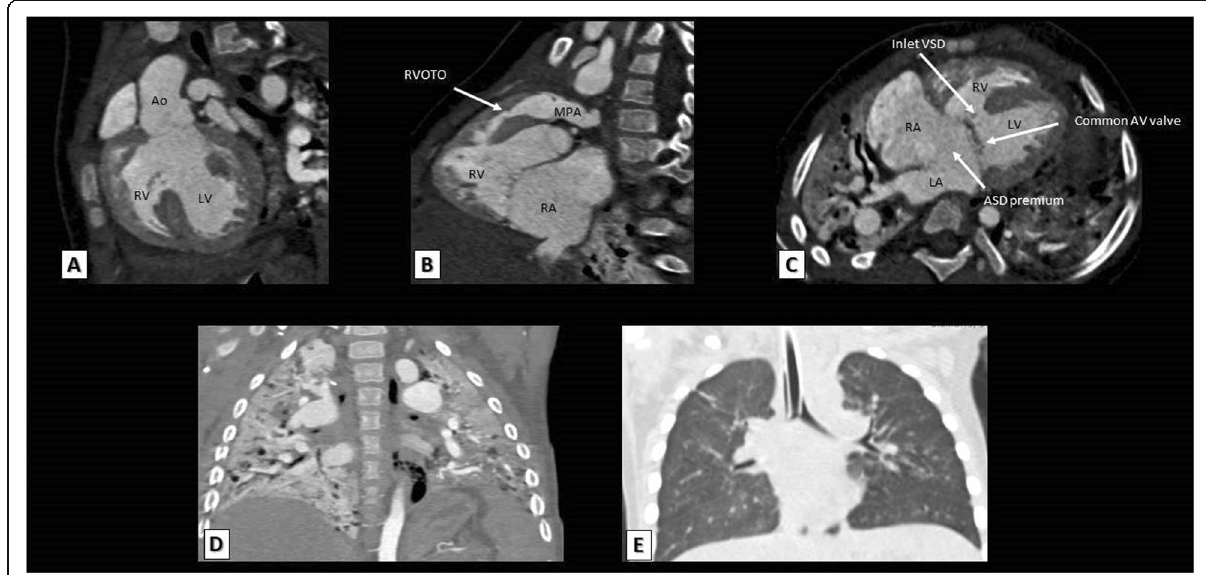
Fig. 3 a , b : Reconstructed MDCT coronal and sagittal images showing overriding of aorta over the VSD ( a ), RVOT obstruction and RV hypertrophy ( b ). c A reformatted MDCT axial image showing a complete AVSD with ostium premium ASD, a common AV valve, and an outlet VSD. d Bilateral transient total lung collapse as a result of airway obstruction during anesthesia, which completely resolved minutes later after airway tube insertion ( e ). Ao, aorta; LV, left ventricle; RV, right ventricle; LA, left atrium; RA, right atrium; MPA, main pulmonary artery; RVOTO, right ventricular outflow tract